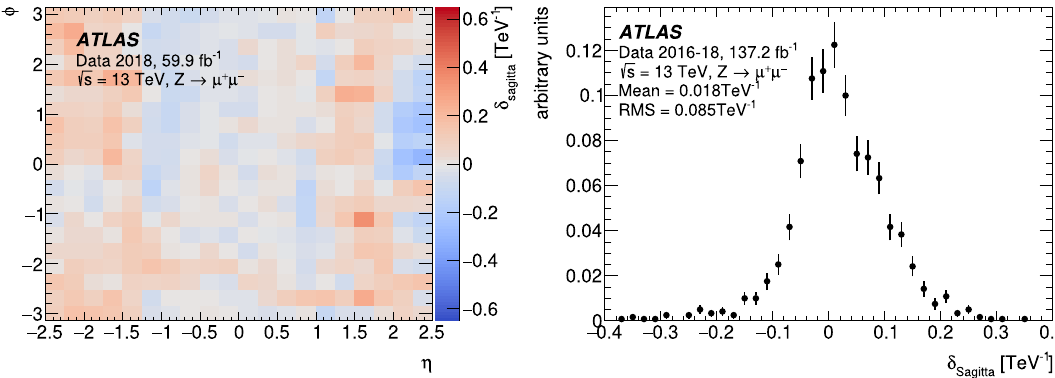
Fig. 18 Sagitta biases versus η and φ (left) for 2018 data and the overall sagitta biases in the Run 2 data (right) for the Z → μ + μ − method. The error bars represent the statistical uncertainty